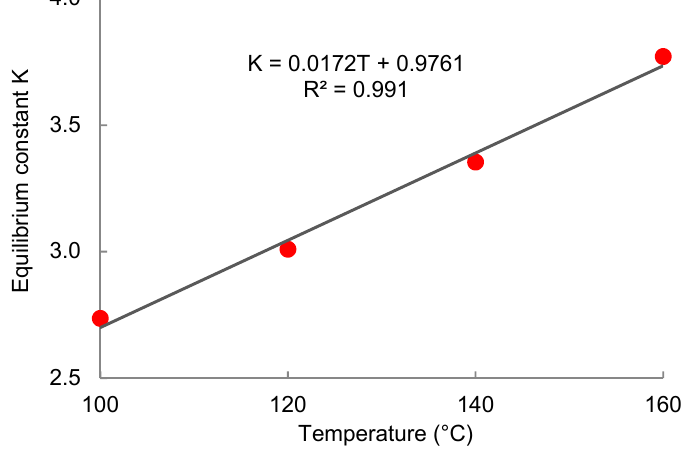
Figure 7. Dependence of the equilibrium constant for oligomeric lactic acid transesterification on the ethanol temperature. Table 2. Kinetic parameters of oligomeric lactic acid alcoholysis with respect to ethanol.